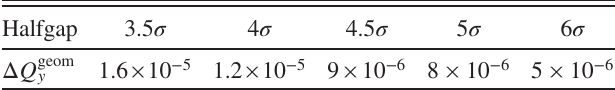
TABLE II. Geometric tune shifts expected for the bunch intensity of 1 . 2 × 10 11 p. In collimator settings, σ is the beam size for a 3 . 5 μ m reference normalized emittance.